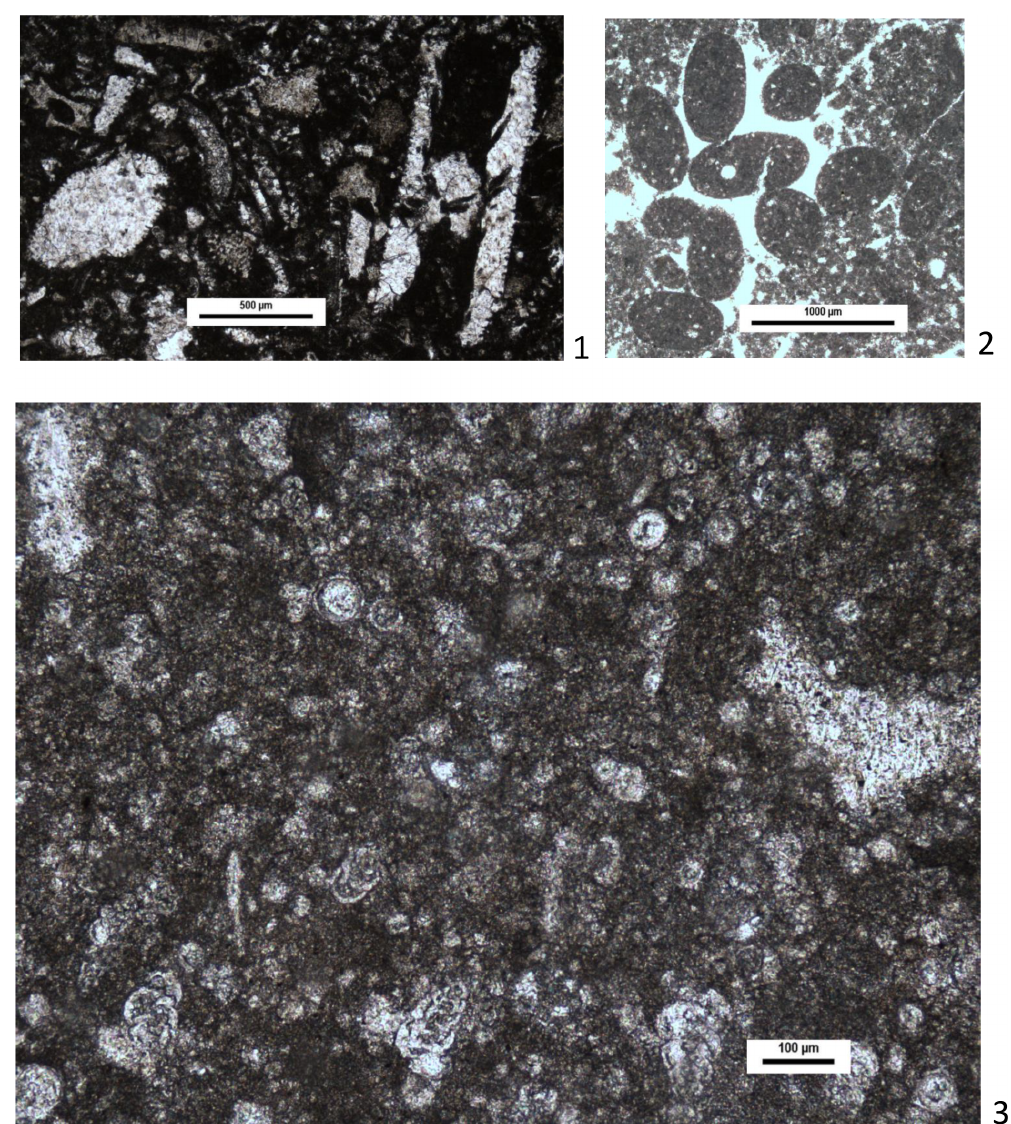
Figure 12. Thin-section photographs of calcareous algae and other microfossils from the Derdere Formation at Derik. (1) Permocalculus ire- nae Elliott, sample DRK3(U); (2) micro-coprolites, sample DRK12(U); (3) calcispheres and indeterminate planktonic foraminifera, sample